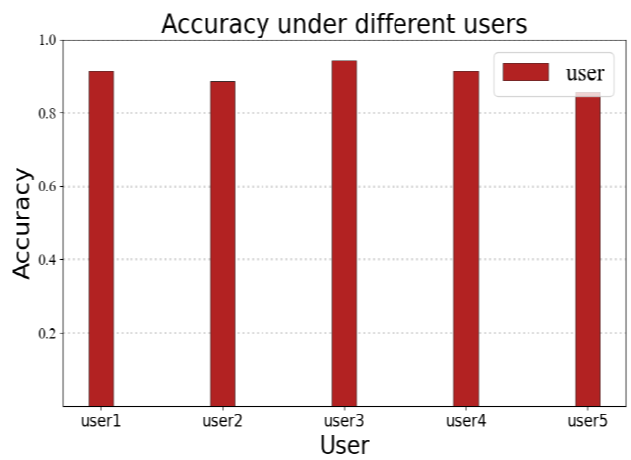
Figure 16. Accuracy rate under different users.